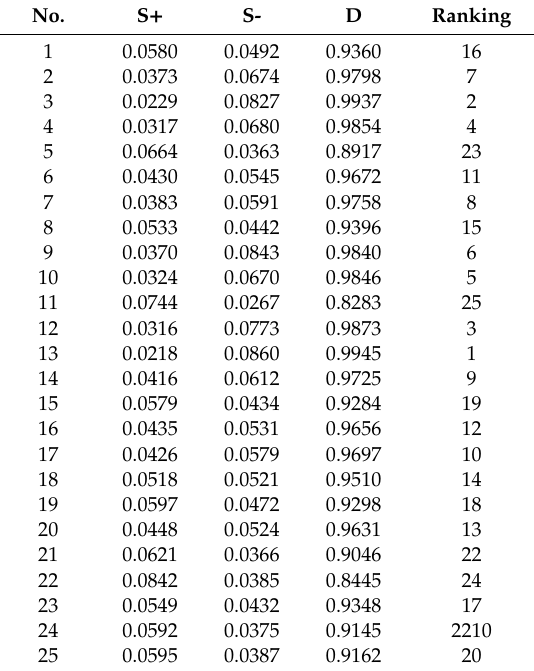
Table 10. Desirability values and ranking.